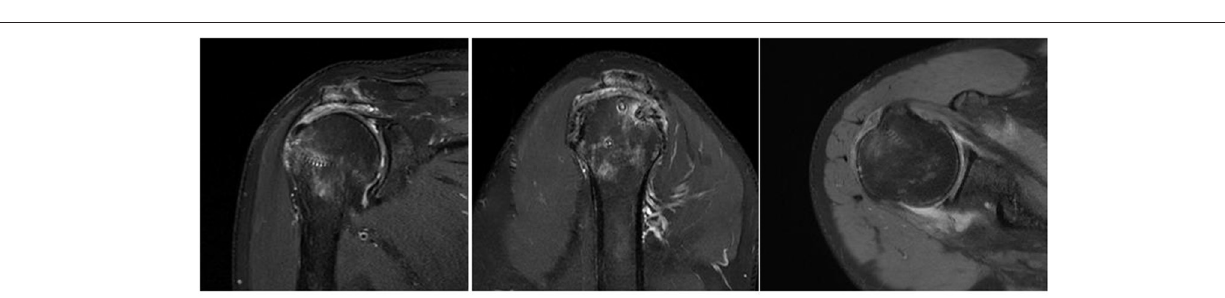
FIGURE 11 | Sugaya’s classification type III in postoperative MRI.